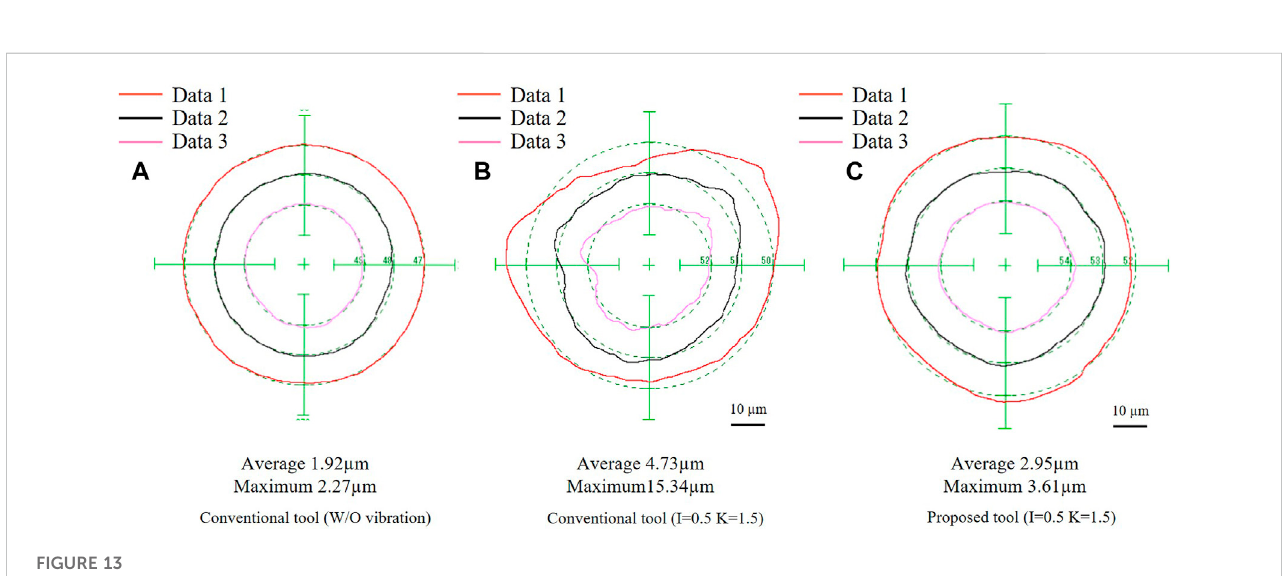
FIGURE 13 Roundness measurement results for the proposed